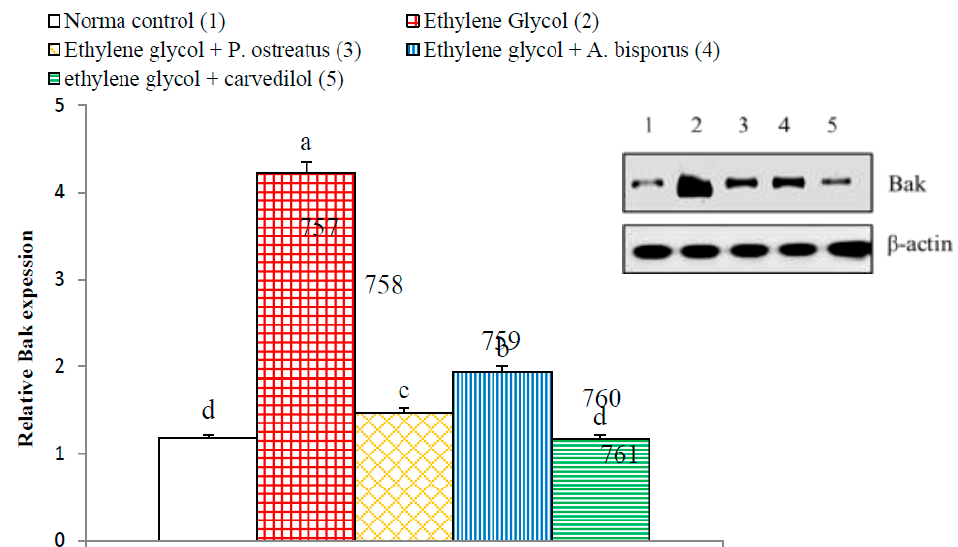
Figure 24. Effect of P. ostreatus and A. bisporus aqueous extracts and carvedilol on relative kidney Bak expression detected by Western blot in ethylene glycol-administered rats. Means which share the same letter(s) are not significantly different.